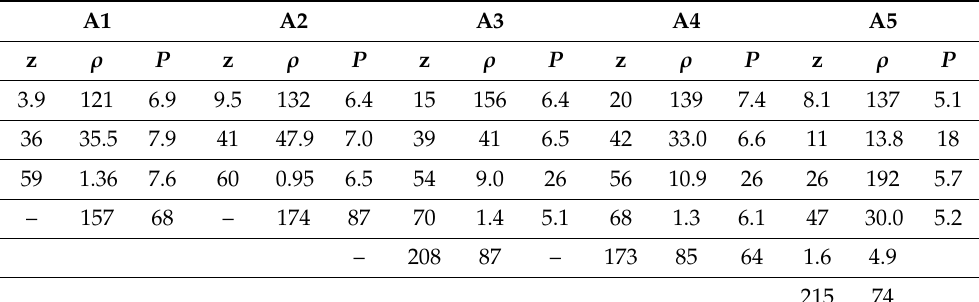
Table 2. Resistivity and polarisability values in October (mid-autumn) were obtained with VES- IPS